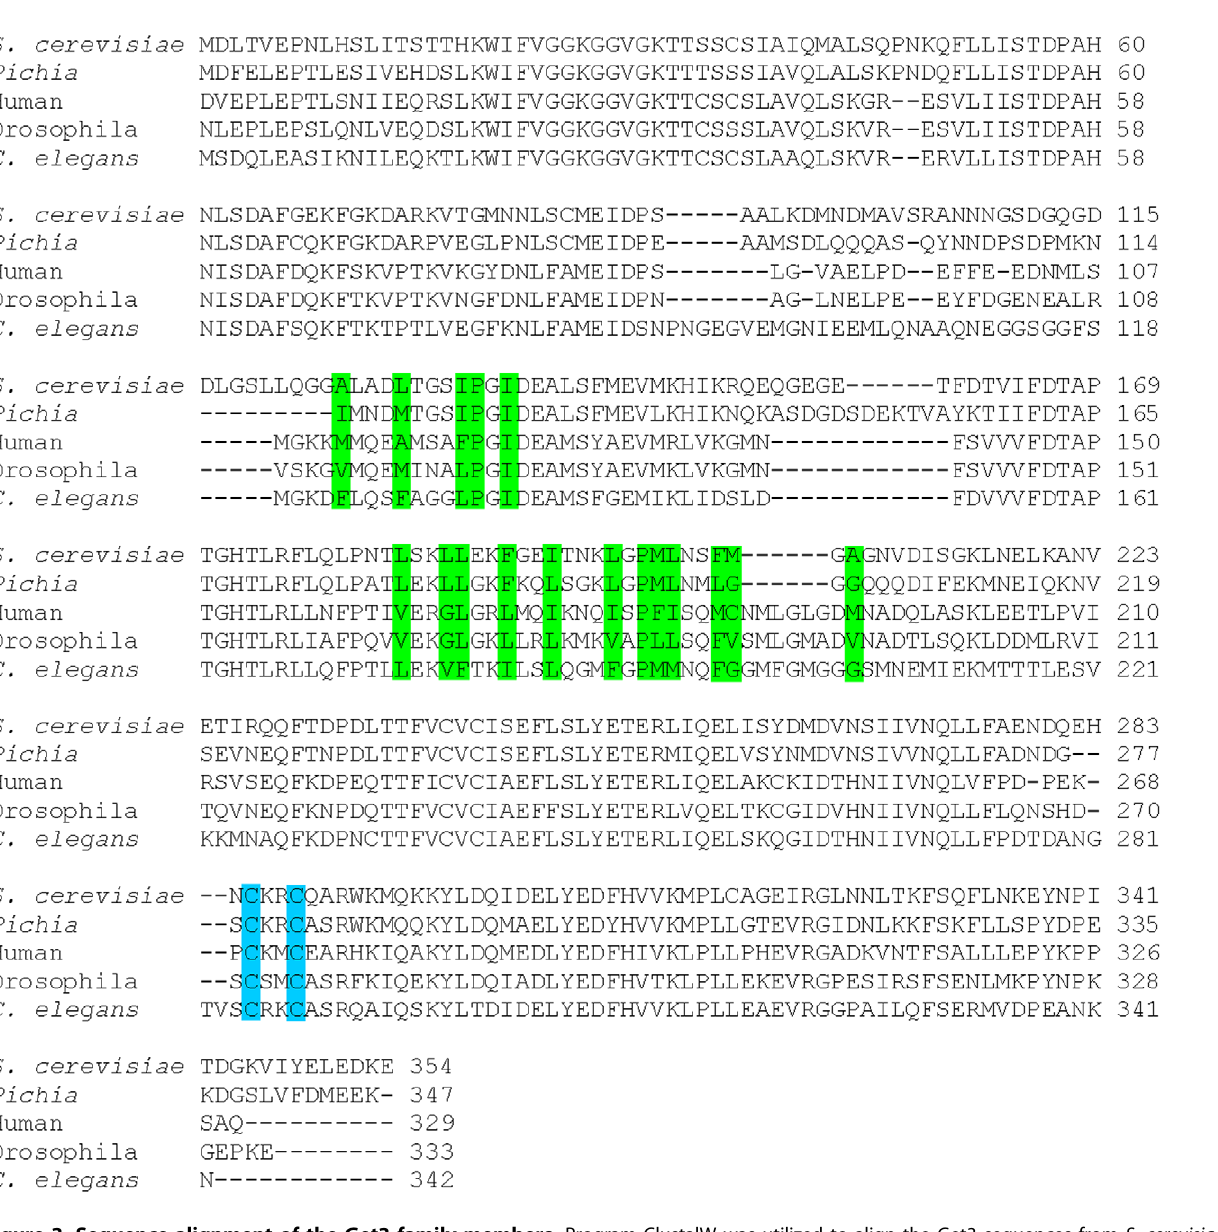
Figure 3. Sequence alignment of the Get3 family members. Program ClustalW was utilized to align the Get3 sequences from S. cerevisiae (yeast) with those from D. hansenii, H. sapiens , D. Melanogaster and C. elegans . The amino acid residues are numbered at the right side of the alignment. The conserved C285 and C288 responsible for the Zinc-finger motif formation are labeled in blue. The conserved hydrophobic residues involved in forming the TMD-binding groove are labeled in